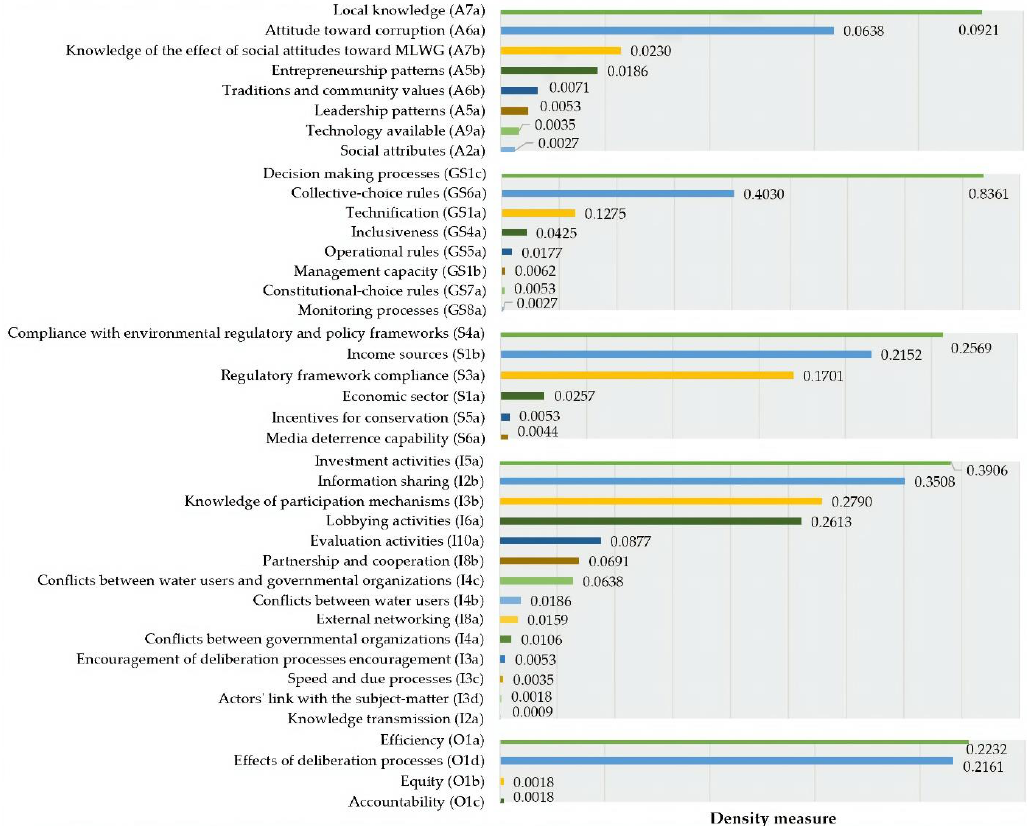
Figure 5. Density of variables affecting multilevel water management. MLWG: multilevel water